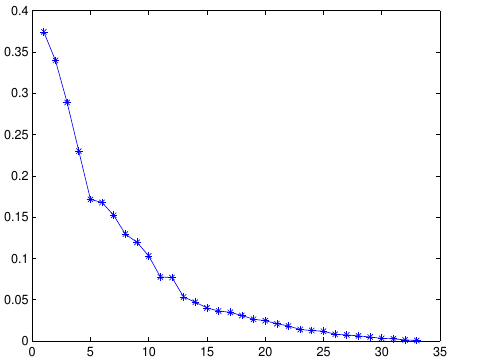
Figure 4. Ordered eigenvalues for l 1 = 0.1, l 2 = 0.4, and σ 2 = 2.